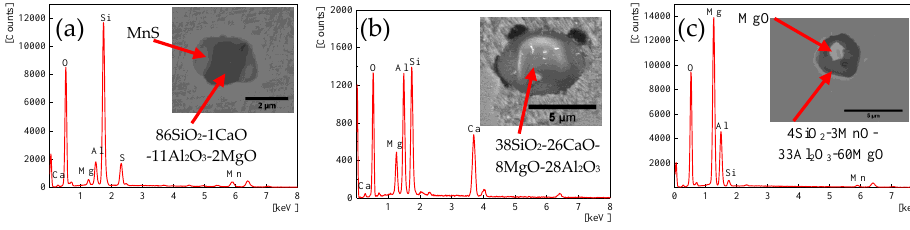
Figure 10. Typical inclusions at the normal experimental heat.